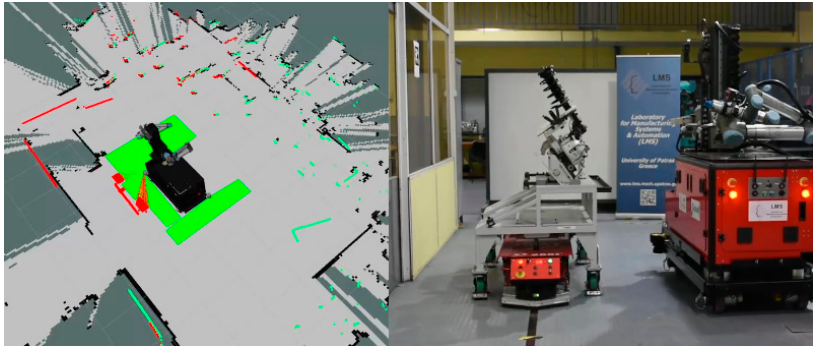
Figure 7. Conavigation . Figure 7.